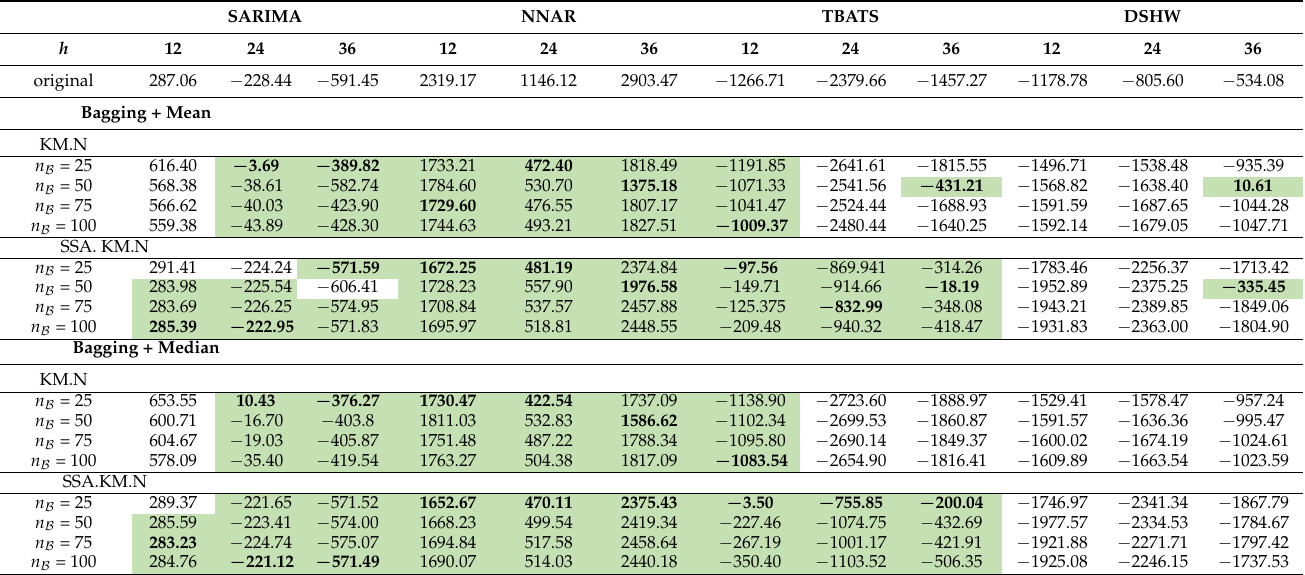
Table 8. MBEs of h -step ahead forecast for the second data set obtained by SARIMA, NNAR, TBATS, and DSHW models.